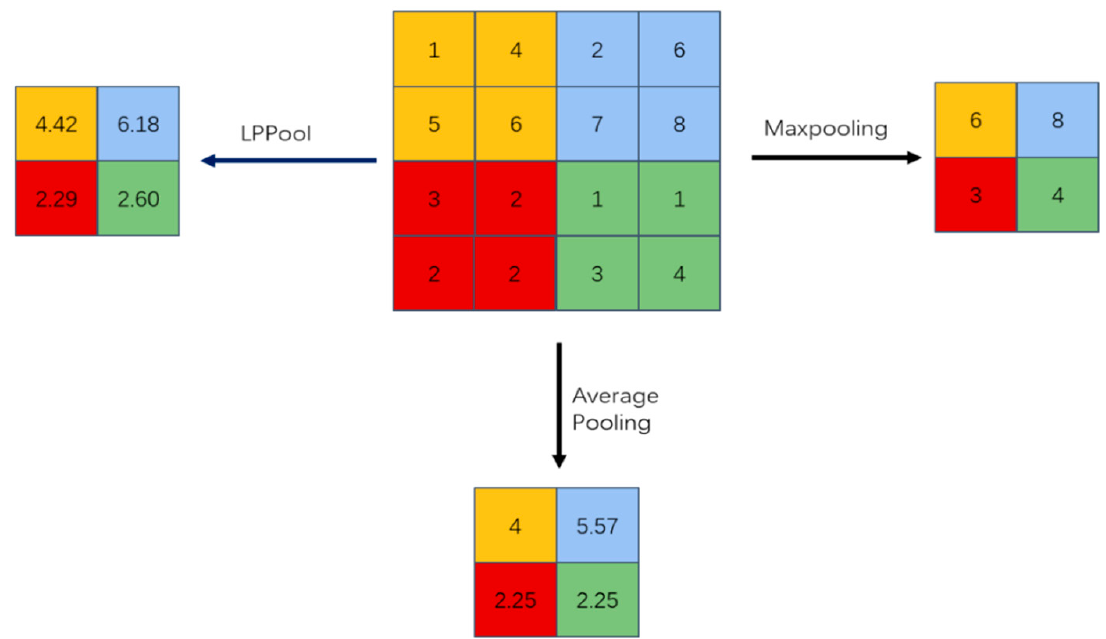
Figure 1. Comparison of the results of three pooling methods: max pooling, average pooling and energy pooling.